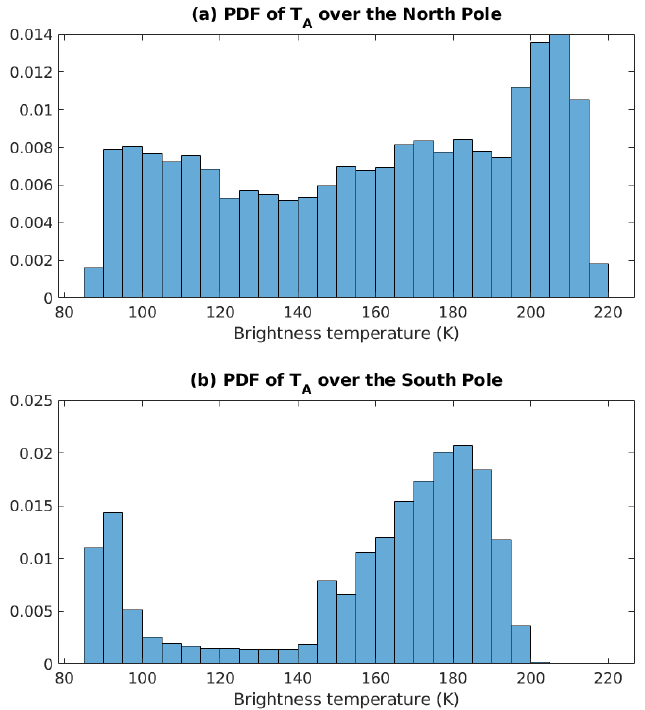
Figure 6. FMPL-2 calibrated brightness temperature ( T A ) PDF for ( a ) the North Pole, and ( b ) the South